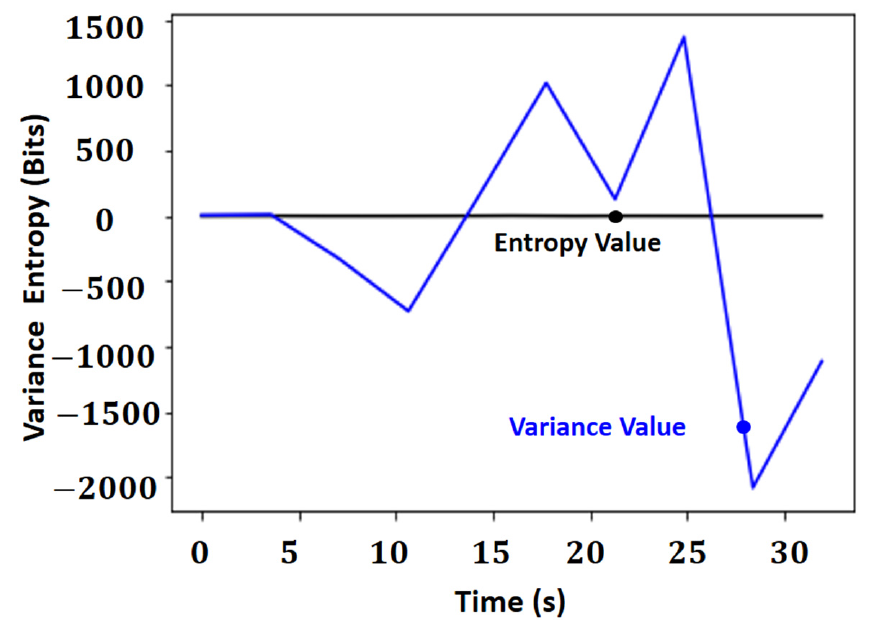
Figure 8. Comparison in the autofocus Laplacian’s entropy operator and the method of minimal differences based on Laplacian’s variance.